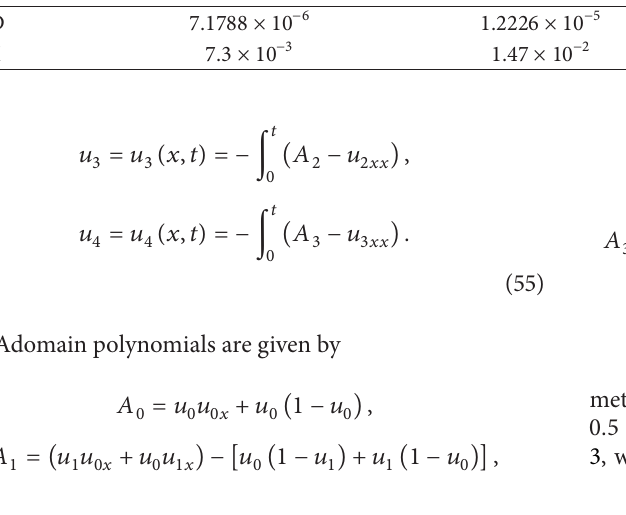
Figure 5: Comparison of NSFD in Section 3 and exact scheme (13) in Section 2 with other stepsizes ℎ = 0.1 and Δ𝑡 for Burgers equation. Table 1: The absolute errors of NSFD method and ADM (𝑛 = 4) for (52) at 𝑥 = 0.1 . 𝑥 =